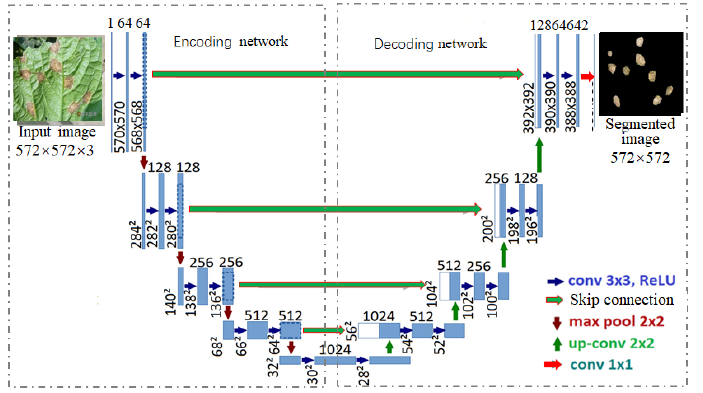
Figure 4. U-Net architecture.